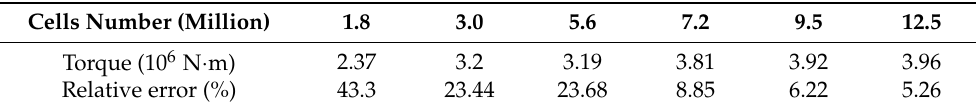
Table 3. The number of grid cells in the rotor domain. Cells Number